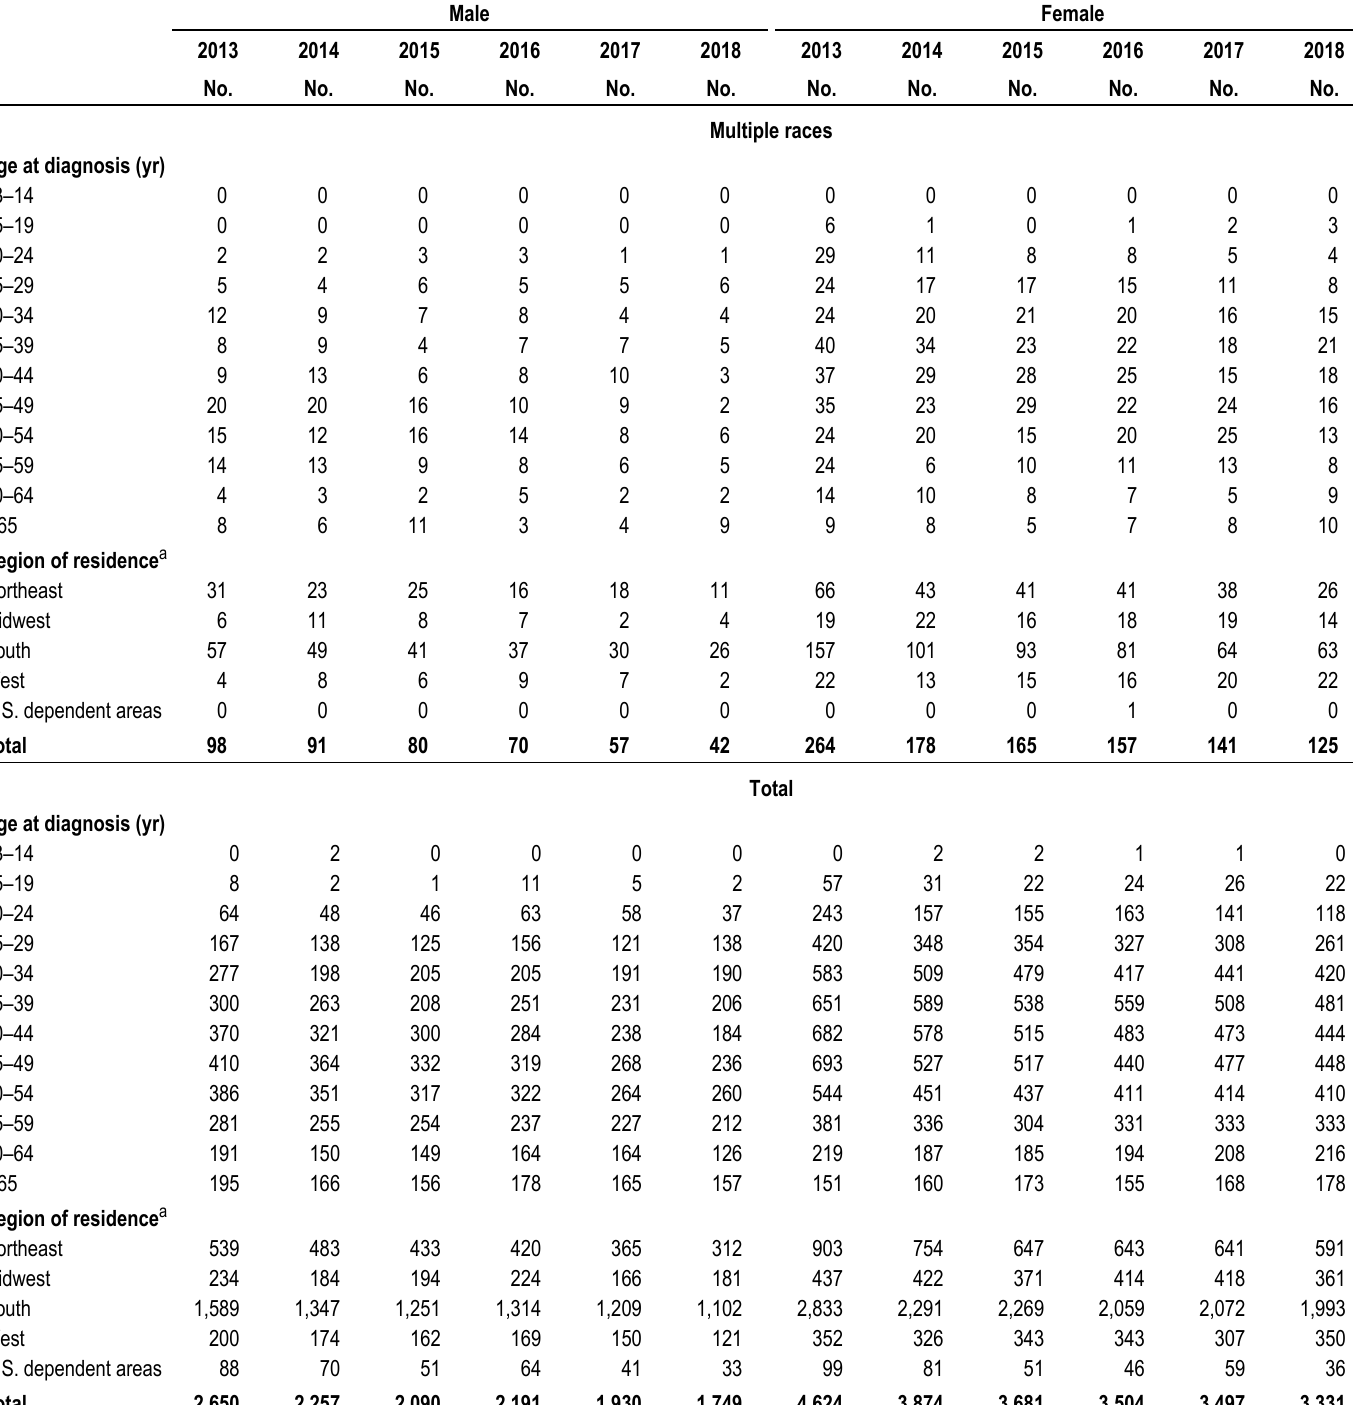
Table 12b. Stage 3 (AIDS) attributed to heterosexual contact, by selected characteristics, 2013–2018—United States and 6 dependent areas (cont) Male